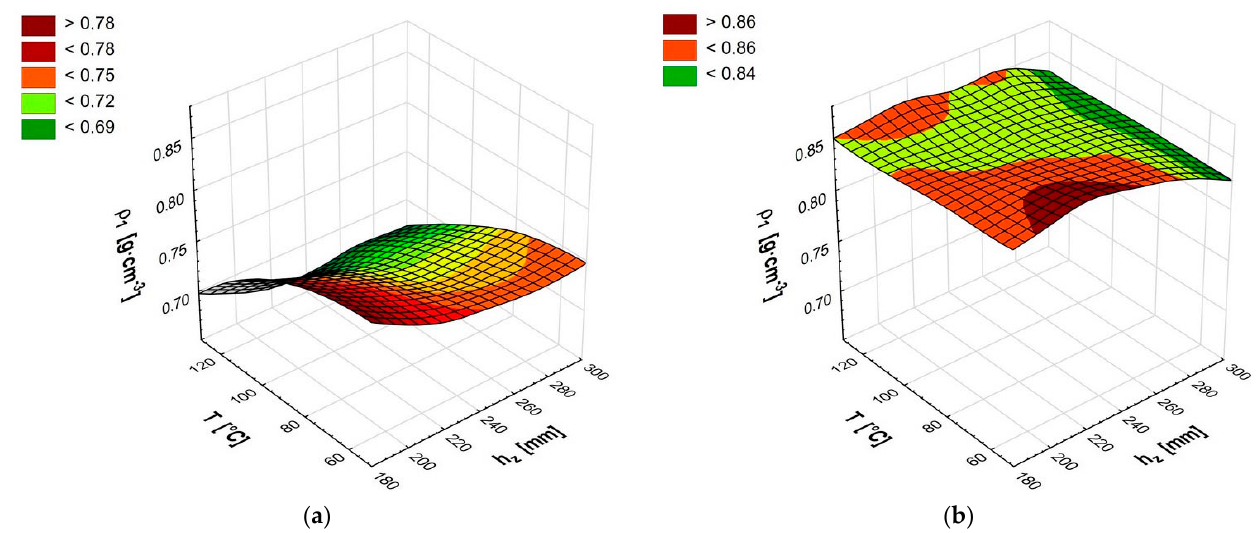
Figure 3. Briquette density after ejection from the die ρ 1 for moisture content 16% ( a ) and moisture content 9% ( b ). Table 3. Results of ANOVA analysis for density of briquette after ejection from the die ρ 1 at two moisture